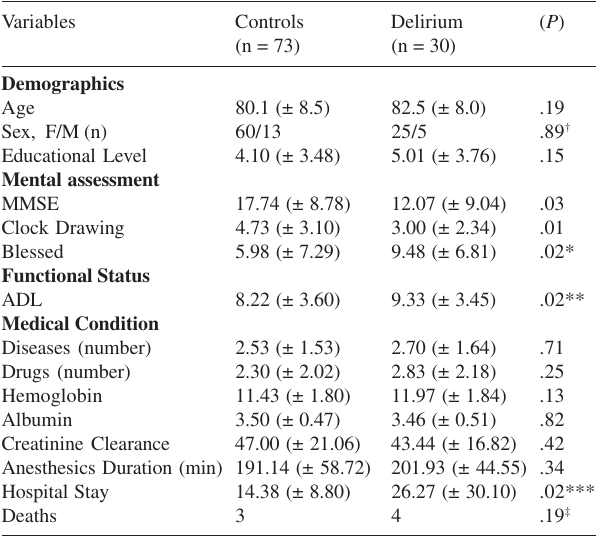
Table 1 - Characteristics of the population (mean, ± SD) Variables